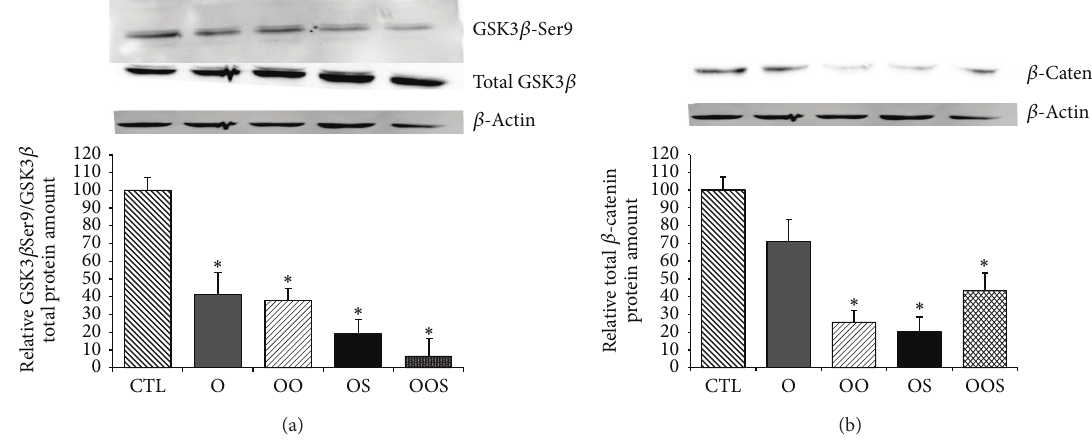
Figure 4: Western blot analysis of Wnt/ 𝛽 catenin pathway modulation. Expression of GSK3 𝛽 Ser9 (upper panel, (a)) and total (middle panel, (a)) and total 𝛽 catenin (upper panel, (b)) were evaluated in osteoblasts grown as described in Figure 1. Lower panel is the loading control ( 𝛽 actin). Quantifications of the data obtained from Western blot analysis are depicted in the graphs. Bars represent mean ± SE of three different independent experiments performed in duplicate. ∗ 𝑃 < 0.05 versus CTL; § 𝑃 < 0.05 versus O.